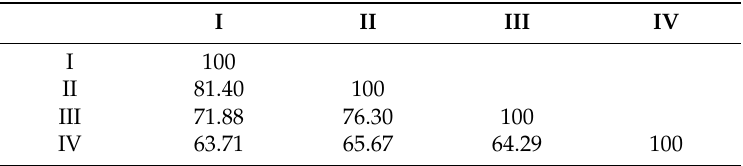
Table 2. The Bray–Curtis similarity values (%) among stages of flower development of L. yunnanensis . (I) bud stage; (II) initial-flowering stage; (III) full-flowering stage; and (IV) end-flower stage.